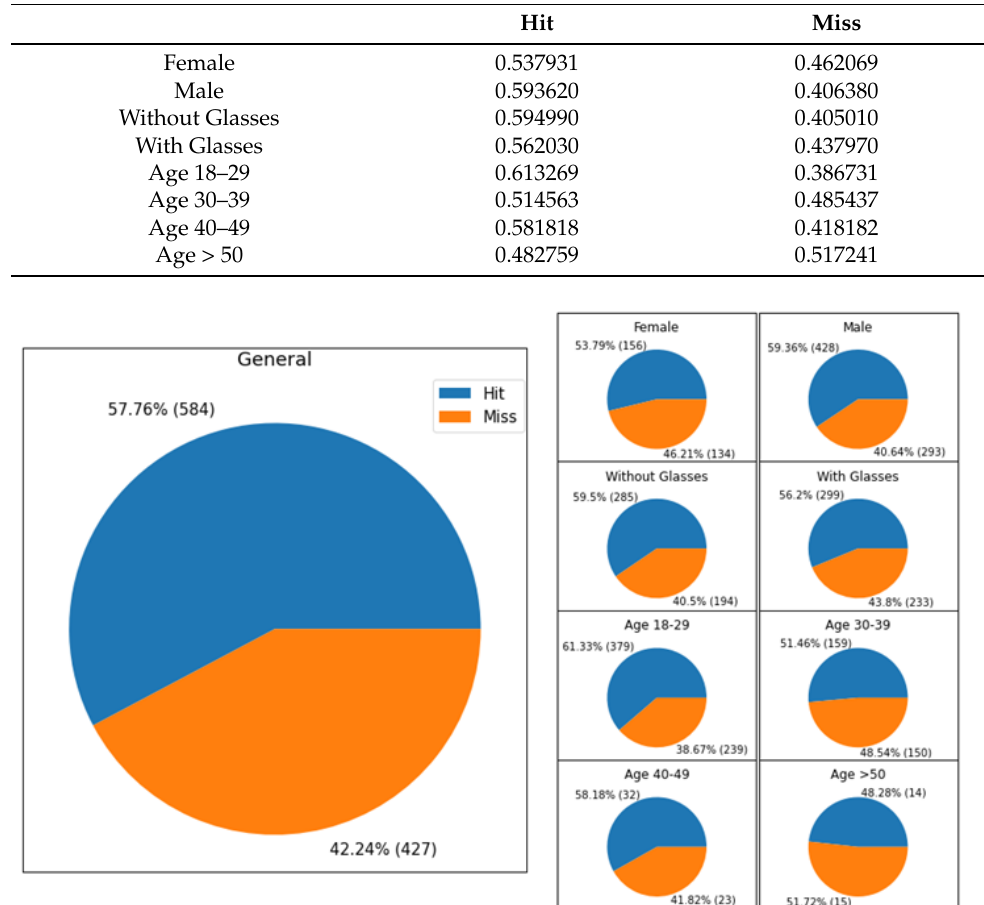
Figure 8. Detailed performances of hit/miss obtained during the subjective